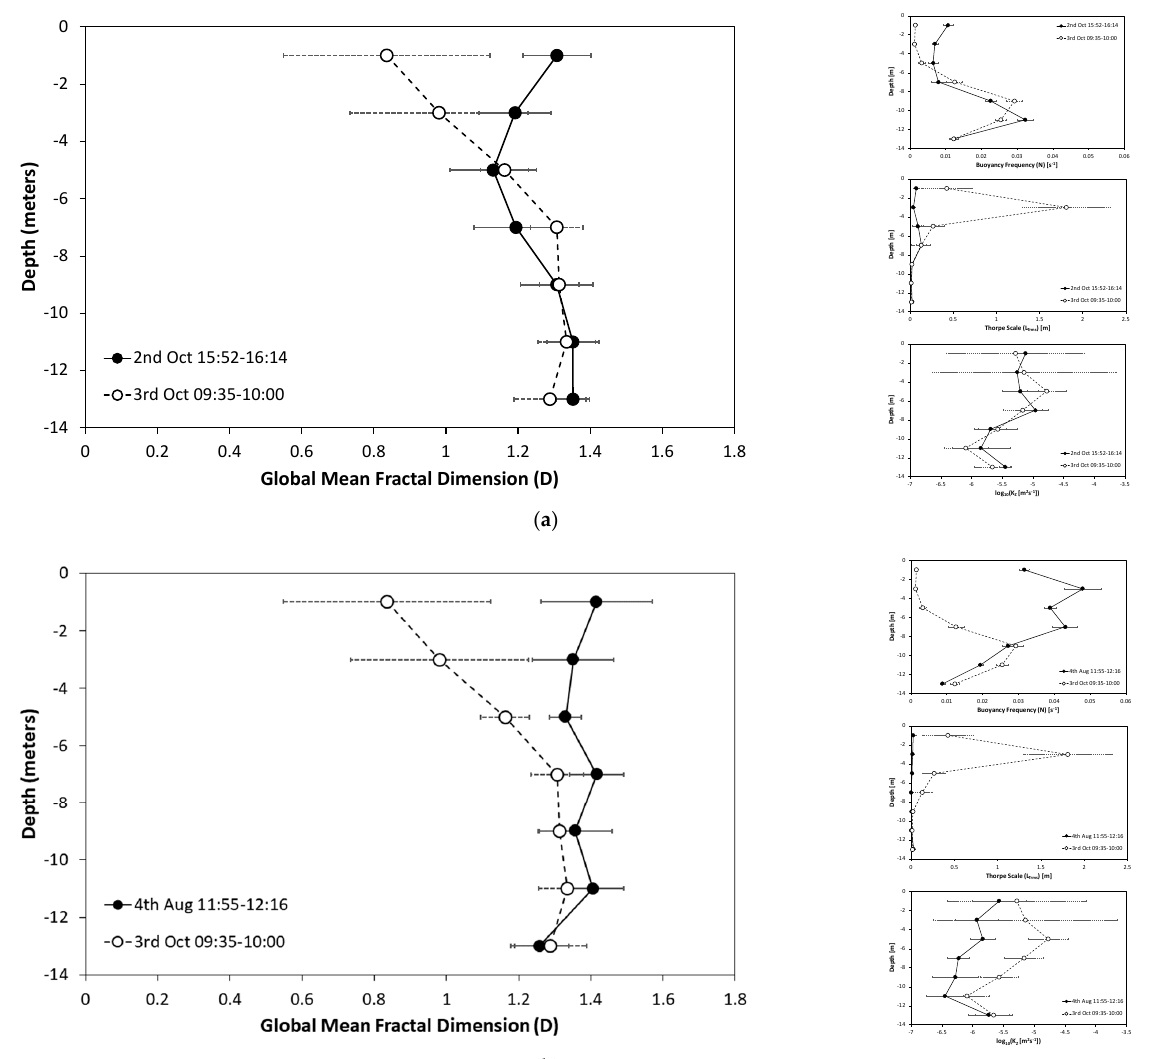
Figure 9. Comparisons of mean (± one standard deviation) values of D in each 2 m-depth bin (left hand panels) for profiles separated by ( a ) daily variations and ( b ) seasonal variations. Right hand panels show buoyancy frequency (top), root mean square Thorpe scale (middle) and log 10 (K Z ) (bottom) for each date, for comparison.